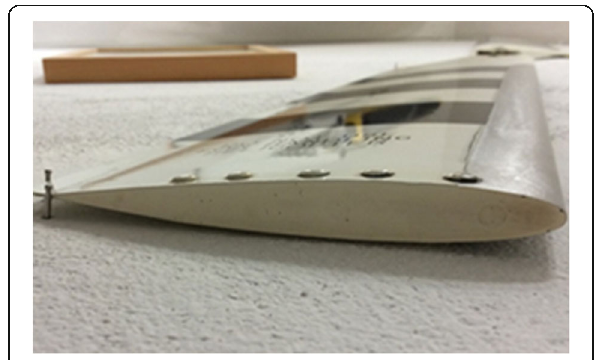
Fig. 15 Control of the assembly state of the piece with the rotor tail